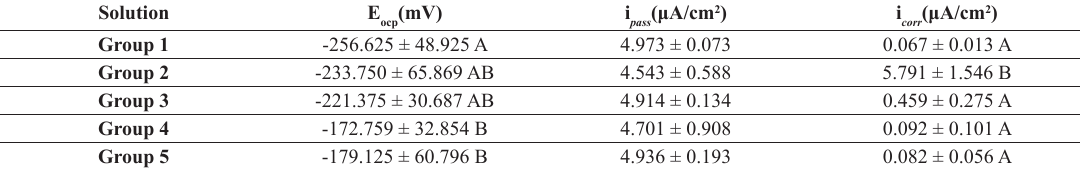
Table 2. Corrosion parameters obtained from potentiodynamic polarization curves of CoCr alloy in different mouthwash solutions and artificial saliva (means and standard deviation). Solution